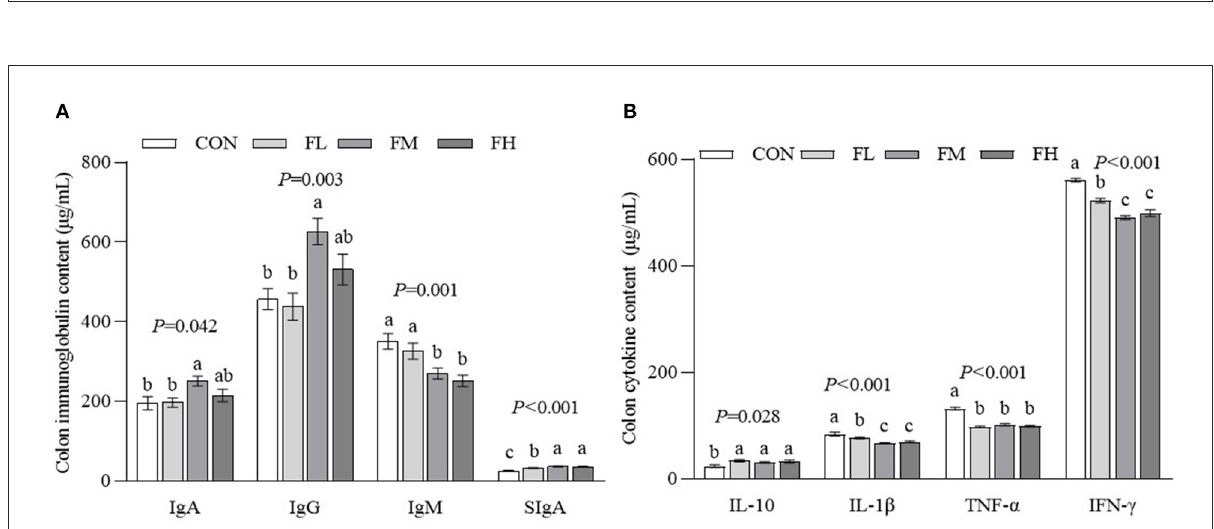
FIGURE5 The effects of fucoidan on colon immunoglobulin and cytokine content in weaned lambs. (A) Colon immunoglobulin concentrations. (B) Colon cytokine concentrations. CON, control; FL, 0.1% fucoidan (DMI); FM, 0.3% fucoidan (DMI); FH, 0.6% fucoidan (DMI). Data are denoted as mean ± SEM ( n = 3). a,b,c Demonstrate a statistically significant distinction, P <